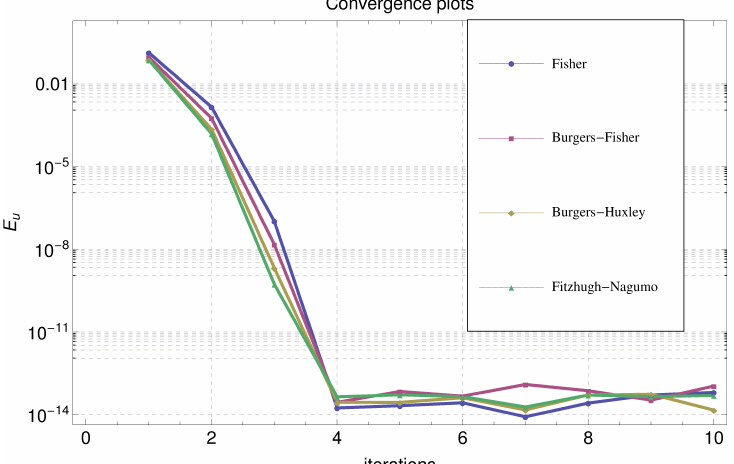
Fig. 6. Convergence graphs for the Fishers, Burgers-Fisher, Burgers-Huxley and the Fitzhugh-Nagumo